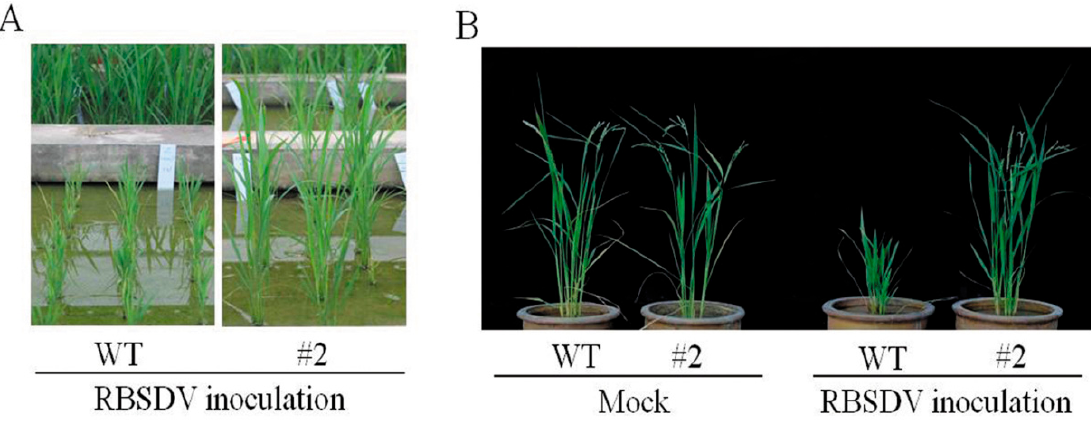
Figure 1. Resistance phenotypes of the transgenic rice plants. Representative plants at 30 days post-inoculation (dpi) ( A ) and 60 dpi ( B ). WT, wild-type Kitaake; #2, hpRNA transgenic rice plant; mock, mock inoculation (negative control). Table 1. Disease assay of the T 3 transgenic rice plants by the artificial inoculation method. Rice Materials